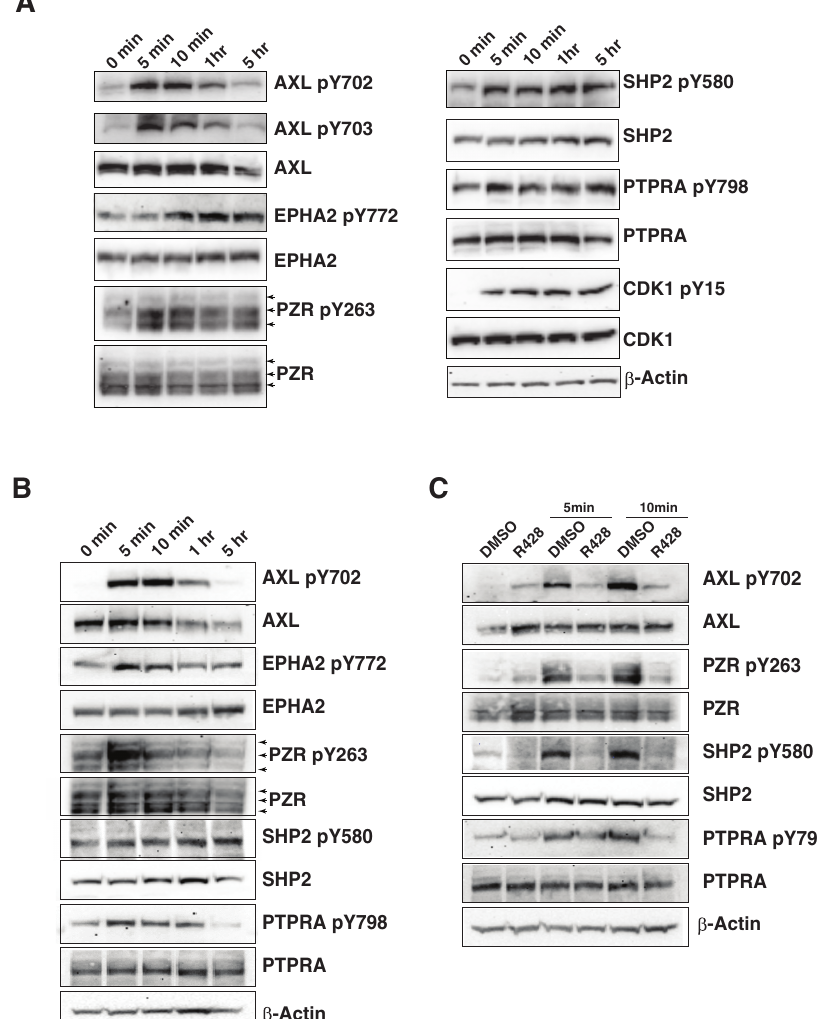
Figure 6. Western blot-based validation of selected molecules in the Axl signaling pathway. ( A ). MDA- MB-231 cells were treated with 400 ng/mL GAS6 for the indicated duration. Cell lysates were analyzed with Western blot analysis using phospho-specific antibodies against EPHA2 (pY772), AXL (pY703/pY702), PZR (pY263), SHP2/PTPN11 (pY580), PTPRA (pY798) and CDK1 (pY15) and antibodies against the corresponding protein as indicated. β -actin served as a loading control. The arrows indicate the three isoforms of PZR protein. ( B ). Western blot analysis to confirm the dynamic regulation of phosphorylation of the indicated proteins in HCC1395 cells treated with 400 ng/mL GAS6 for different time courses (as indicated). ( C ). MDA-MB-231 cells were pretreated with 2 µ M R428 prior to GAS6 stimulation for 5 or 10 min, respectively. Protein phosphorylation levels were detected by indicated phospho-specific antibodies. (The original western blot images were included in Figure